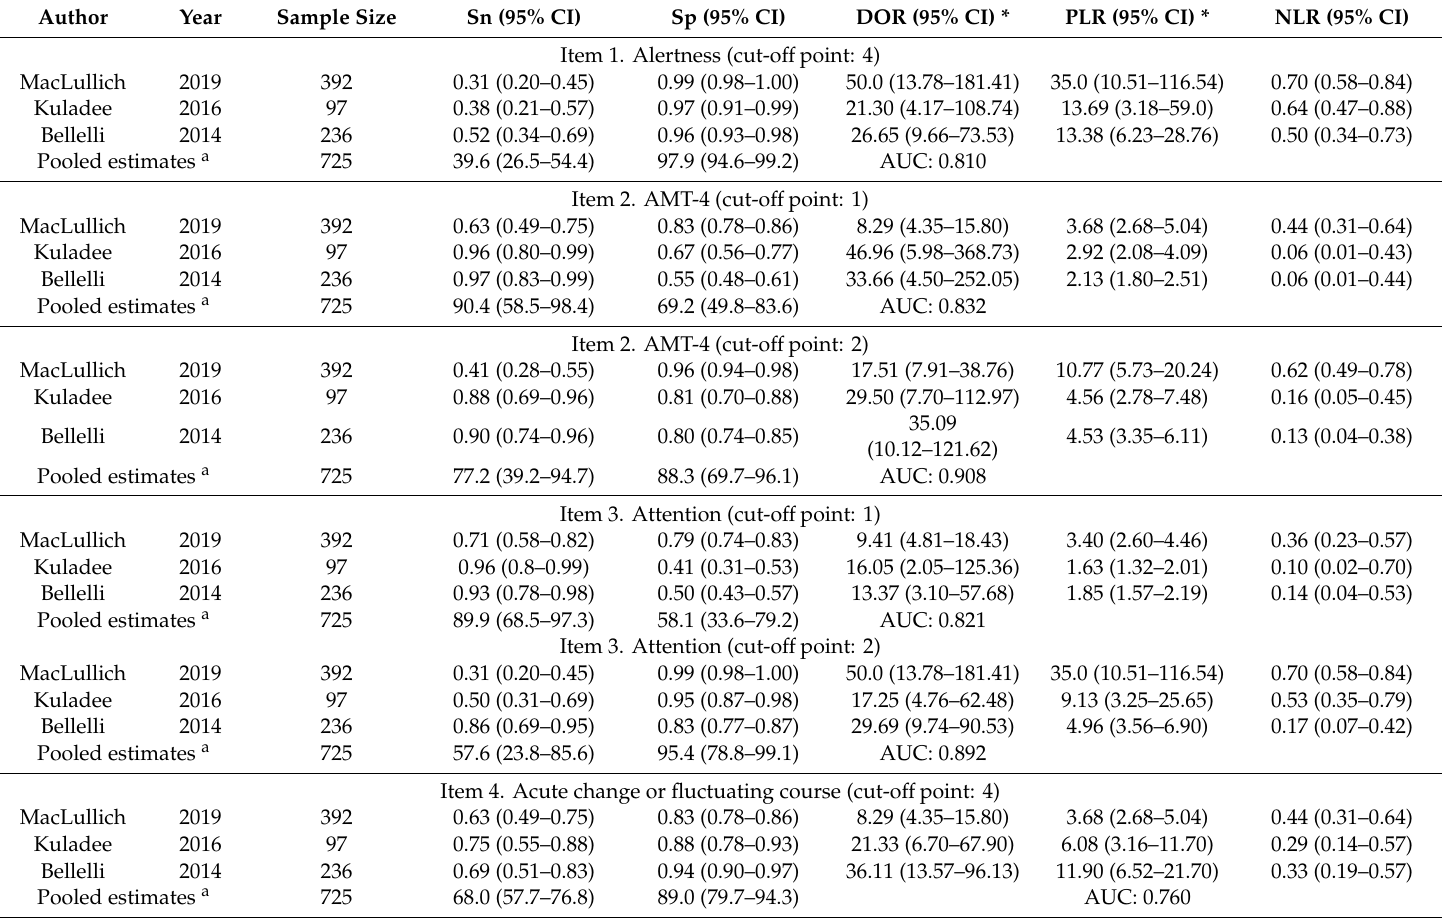
Table 4. Diagnostic test accuracy of each item of the